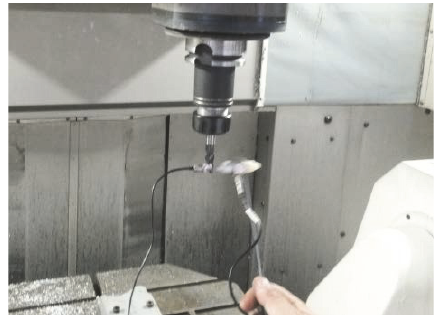
Figure 4: Test of modal parameters of tool system.